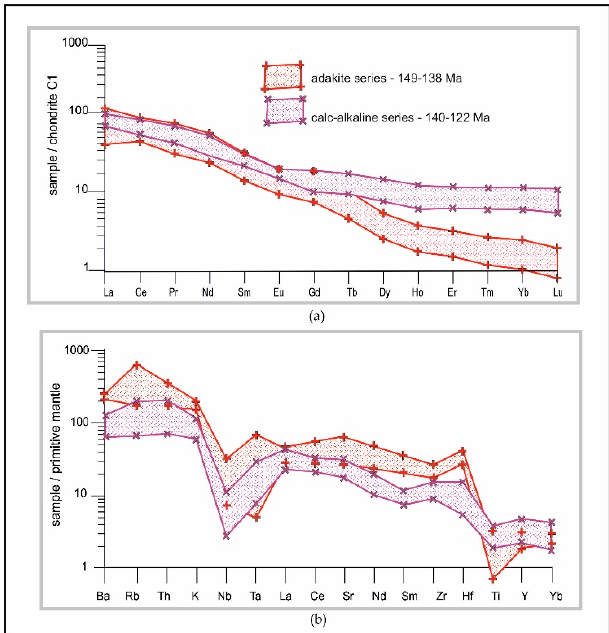
Figure 4. Concentrations of the rare elements in the granitoids of the EF MOOB framing standardized to the composition of Chondrite ( a ) and primitive mantel ( b ). Compositions of chondrite C1 and primitive mantel are brought according to the data [31]. Symbols of granitoids: adakite series (1), calc-alkaline series (2).